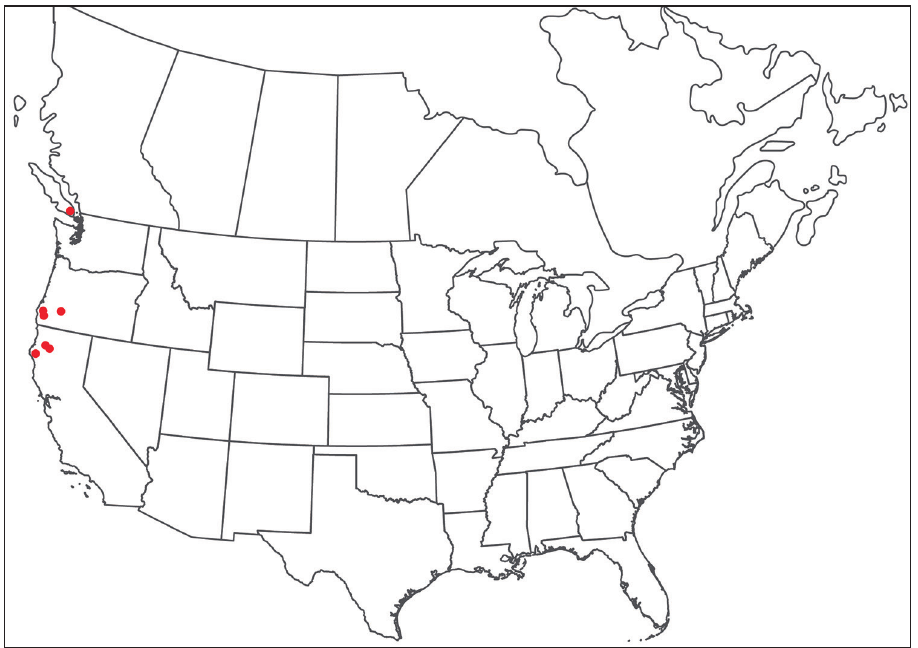
Figure 175. Torrenticola olliei sp. n.